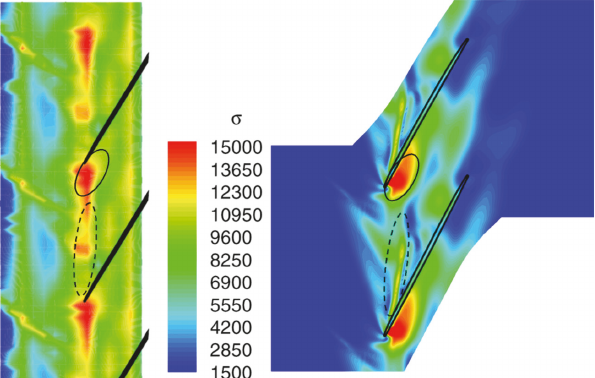
Figure 6: Experimental verification of ([12]). Figure reproduced from LIN et al.